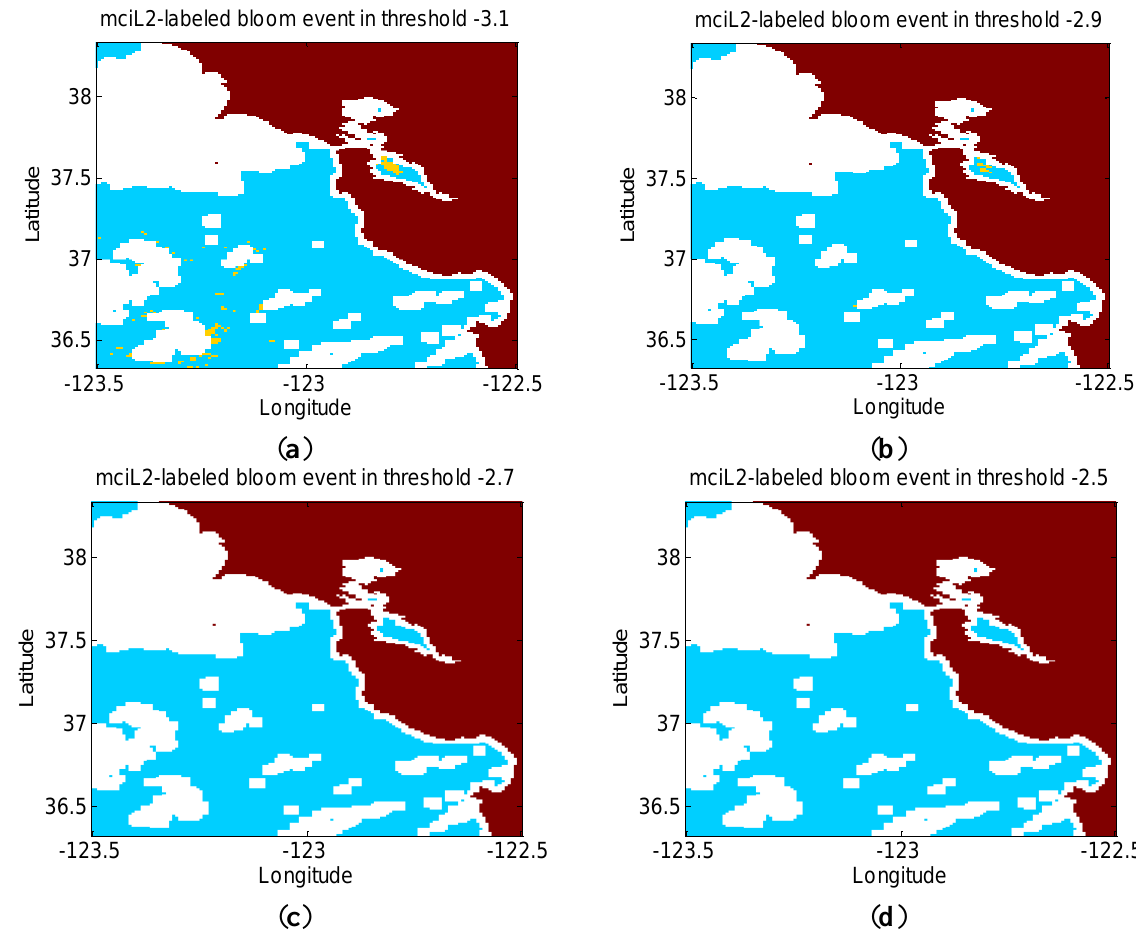
Figure 5. MCI-based bloom phenomenon appearance test using various thresholds on 1 February 2011. The MCI thresholds are at the top of each subfigure ( a – d ). Yellow means HAB, red means land, blue represents ocean without HAB, and white means no